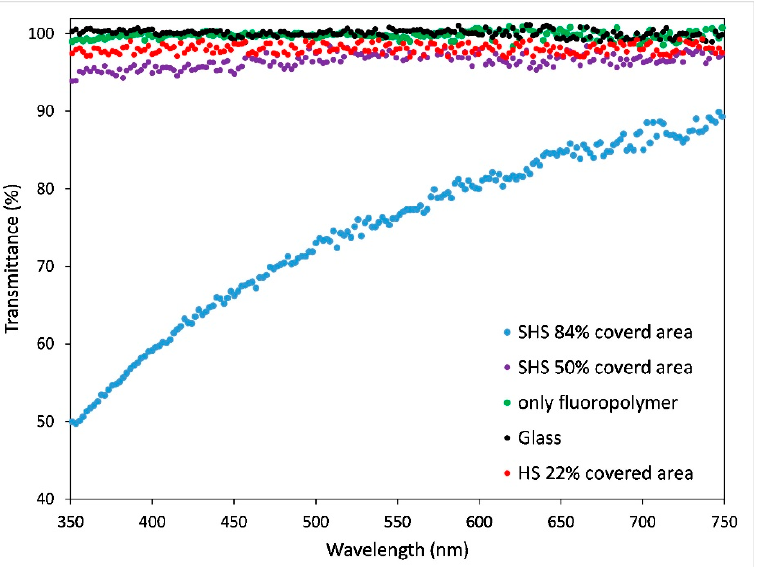
Figure 7. Optical transmittance as a function of wavelength (nm) for bare glass and fluoropolymer coated glass, as a reference, and coated SH and hydrophobic samples with different percentages of covered area by nanoparticles. Red dots (1 g/L 1 layer), purple (2 g/L 1 layer), blue (0.5 g/L 10 layers).